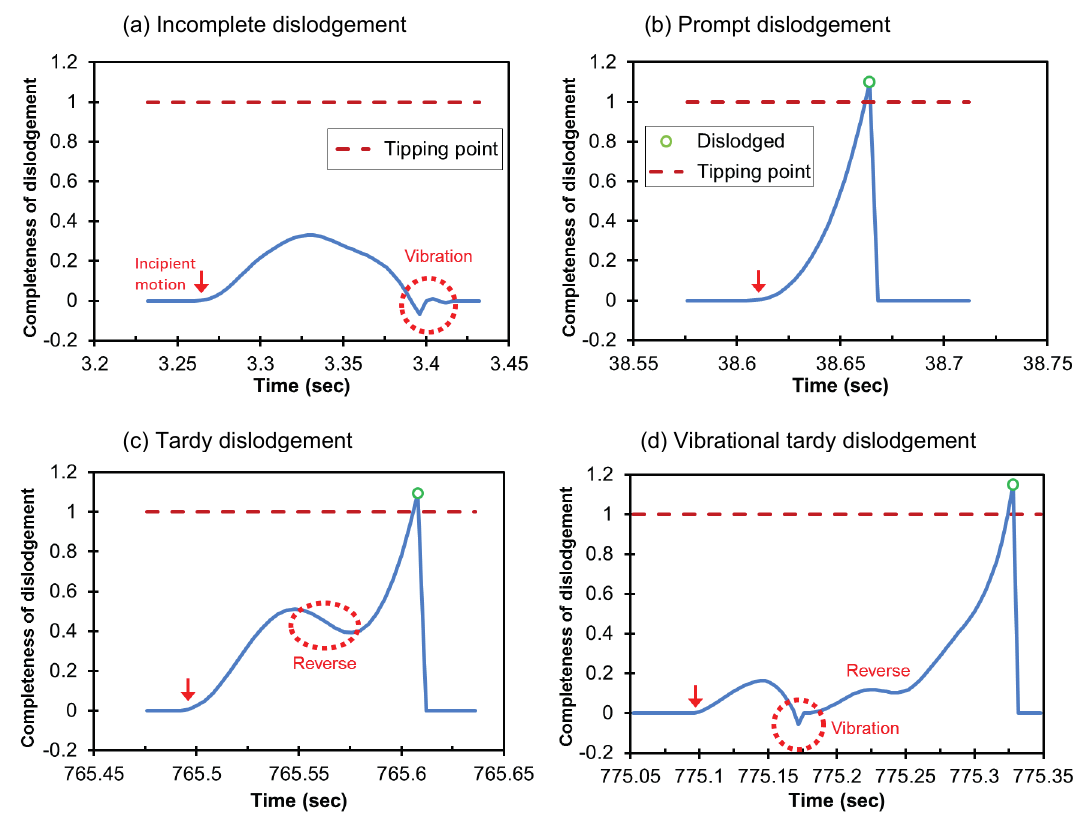
Fig. 3 Types of particle